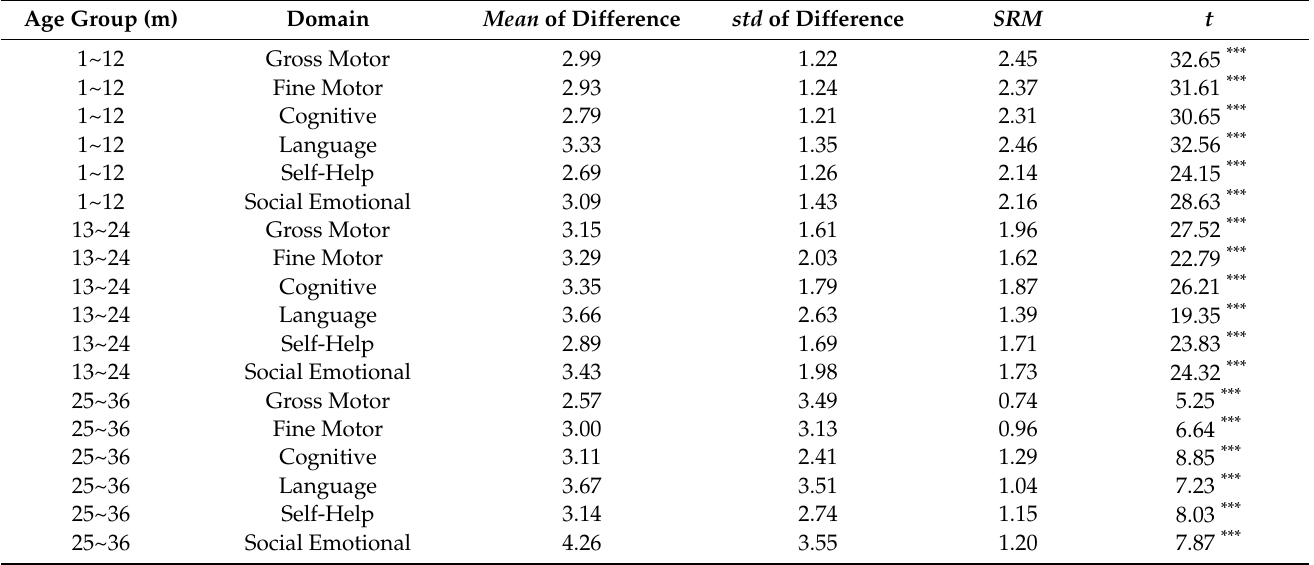
Table 10. Paired t -test result and standardized response mean ( SRM ) for children’s developmental age, obtained from two tests with a time gap of 3 months.